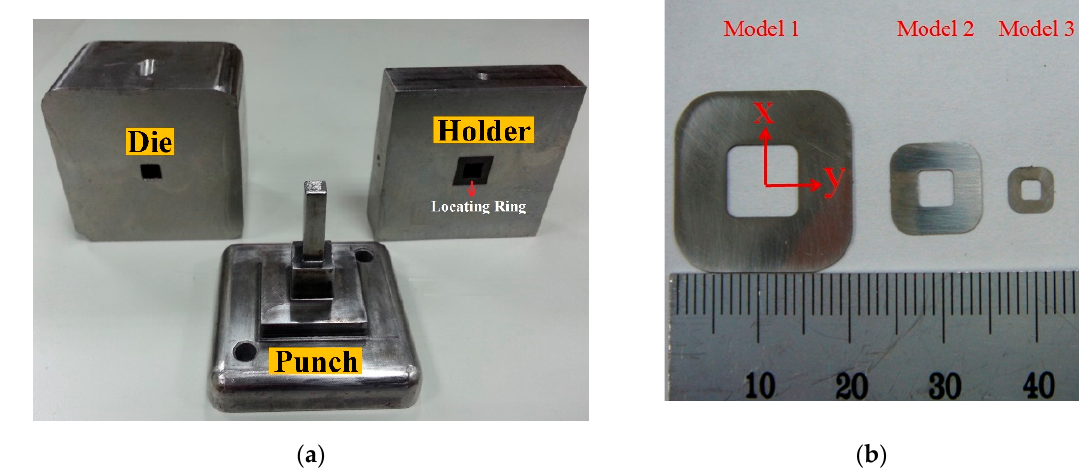
Figure 4. ( a ) Key components of the mold; ( b ) SUS304 stainless steel workpiece specimens used in the experiments. The final specimens, stainless steel sheets with square flanged holes after punching and rebound, are shown in Figure 5.